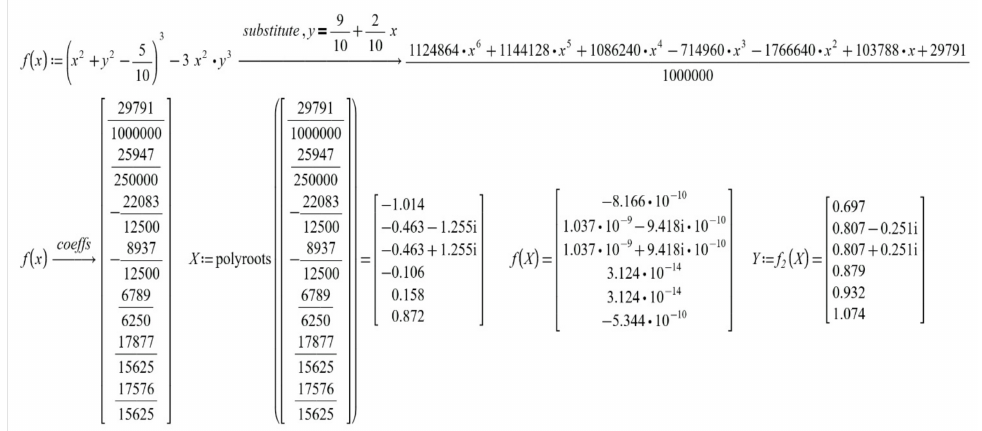
Figure 13. Finding the roots of system (2) using the polyroot function and checking the found